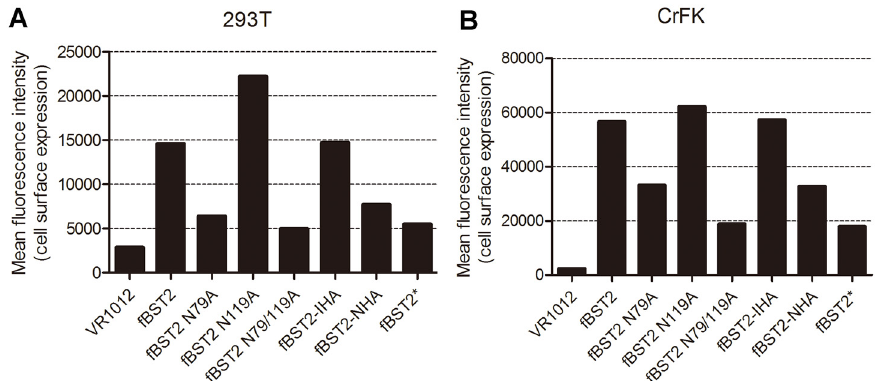
Fig 6. Cell surface expression of BST2 variants. 293T and CrFK cells were co-transfected with 500 ng of VR1012, fBST2, fBST2 N79A, fBST2 N119A, fBST2 N79/119A, fBST2-IHA, fBST2-NHA or fBST2 * expression plasmid, along with 500 ng of pEGFP-N3 as a transfection marker. After 48 h, cells were harvested and stained with the anti-fBST2 pAb and Alexa 633 goat anti-rabbit IgG, followed by flow cytometric analysis. Cells only transfected with pEGFP-N3 were used as a negative control. The samples were gated on EGFP + cells, and the surface BST2 levels are shown in the column diagram with mean fluorescent intensity values (A and B). This experiment was repeated three times, and the most representative data are shown.